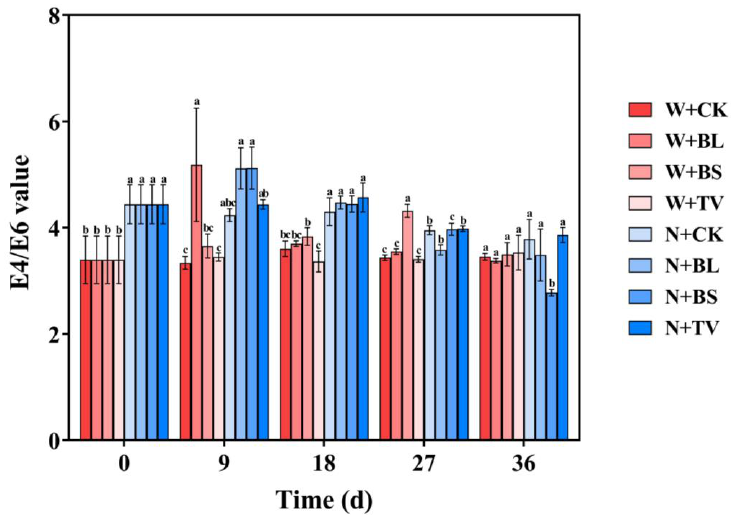
Figure 4. Changes in E4/E6 values in the treatments. Means ± SEs with different letters in each pa- rameter indicate significant statistical differences ( p <